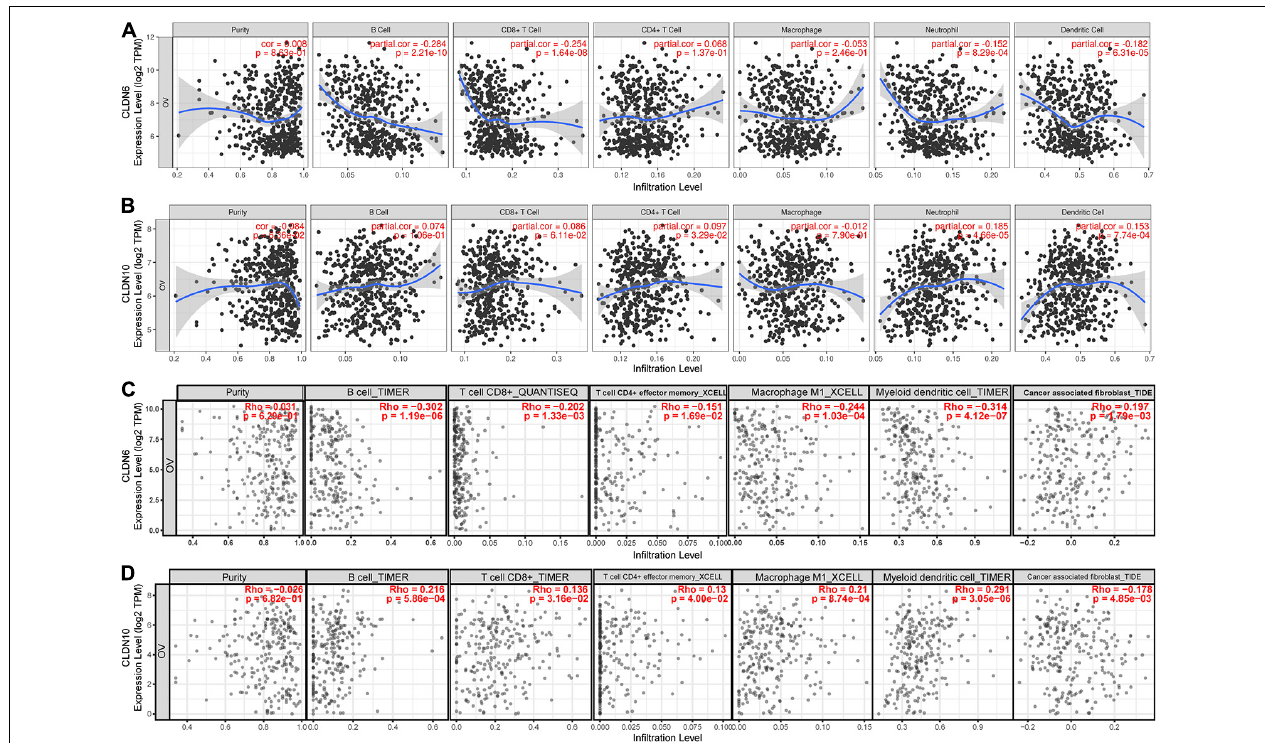
FIGURE 6 | The relationship between immune cell infiltration and claudin expression. Correlation analysis of immune cell infiltration and CLDN6 expression (A) , and CLDN10 expression (B) based on the microarray expression values of ovarian cancer through TIMER. Correlation analysis of immune cell infiltration and CLDN6 expression (C) , and CLDN10 expression (D) based on available TCGA RNA-seq data of ovarian cancer via